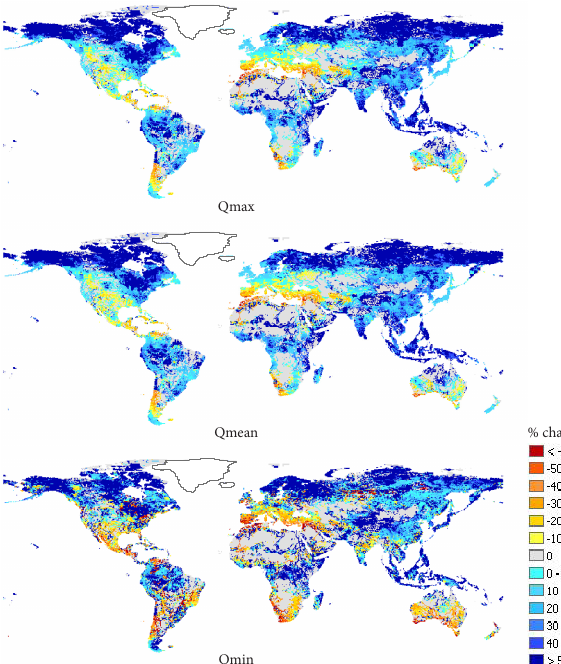
Fig. 3. Maps showing the multi-model ensemble average percent- age change (%) in the hydrological parameters annual maximum, minimum and mean discharge for the emission scenario A1B rela- tive to the 20C3M control experiment.